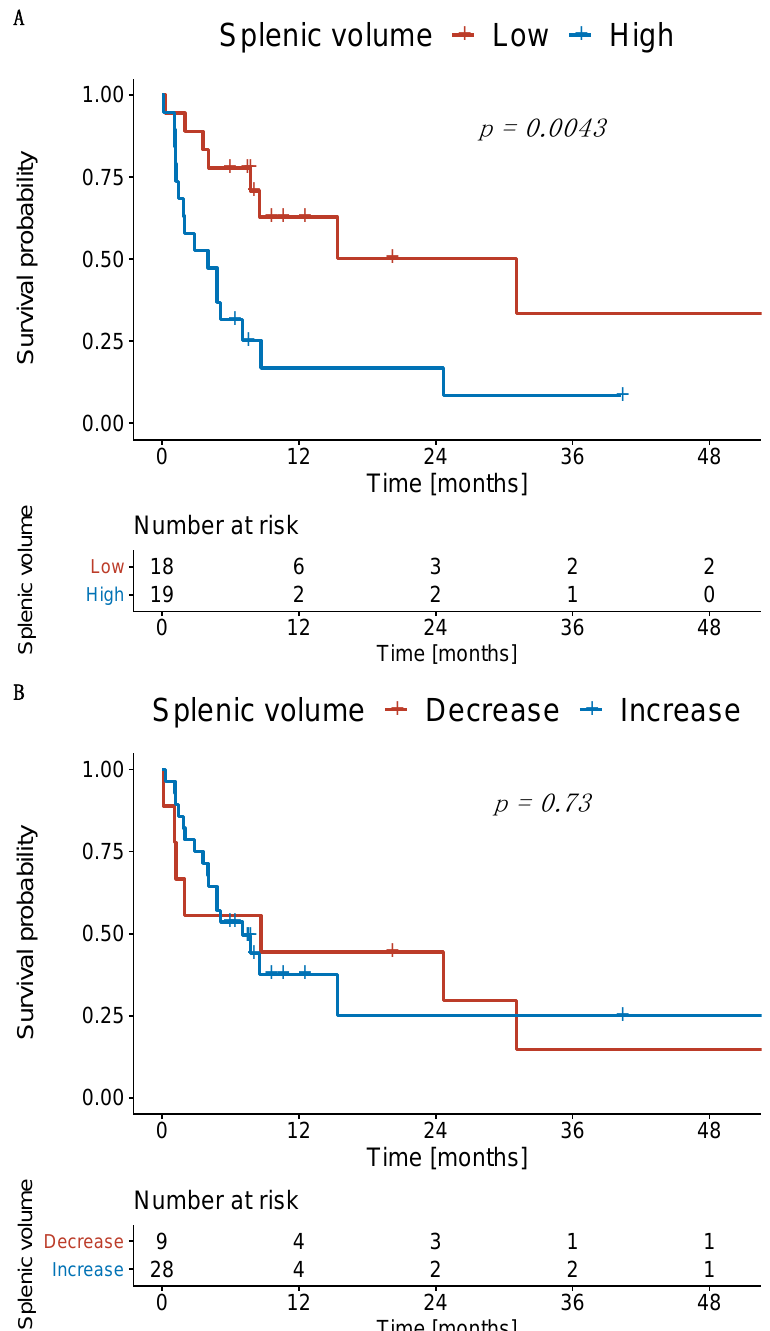
Figure 5. Kaplan – Meier curves for overall survival. ( A ) Patients stratified according to the splenic volume at first follow-up and ( B ) according to the relative change compared to baseline.